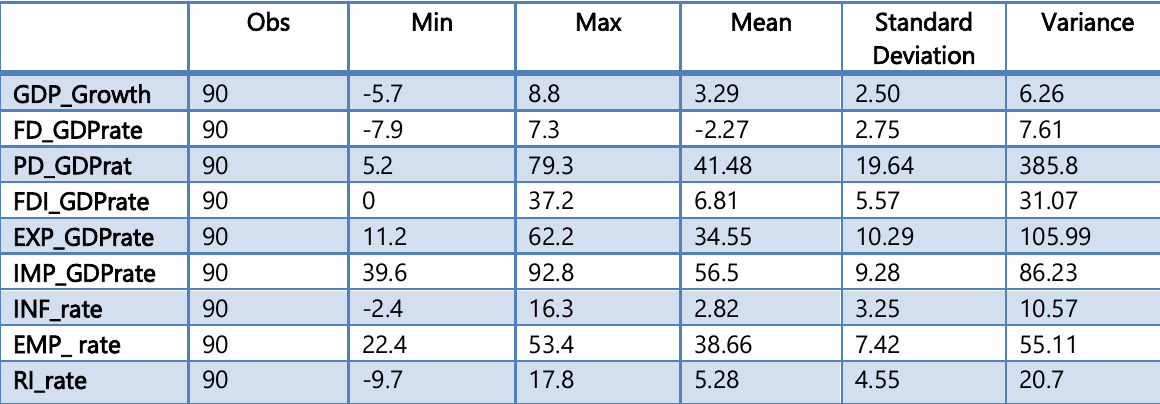
Table 2: Summary Statistics (Source: Authors‟ calculations) Obs Min Max Mean Standard